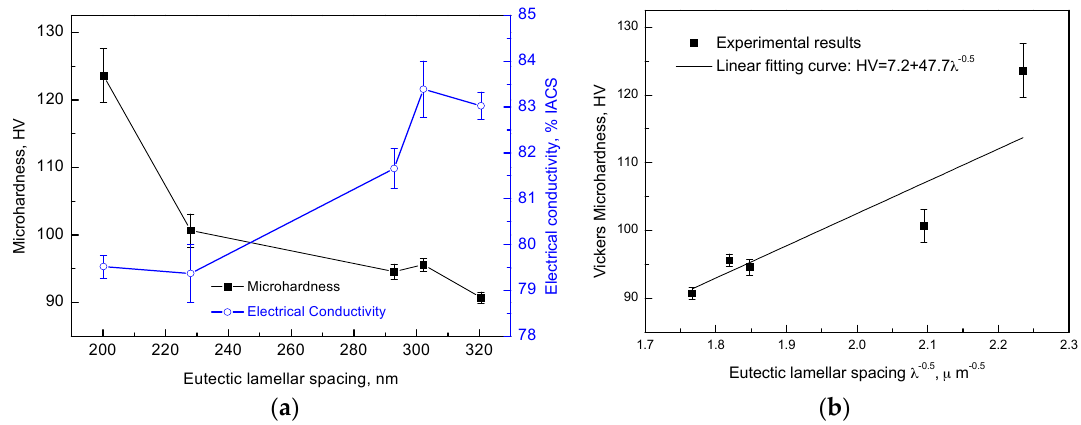
Figure 4. ( a ) Microhardness and electrical conductivity plotted as the ELS of DS Ag-Cu eutectic alloys with different MFs and growth rates; ( b ) Variation of microhardness as a function of the reciprocal square root of average interlamellar spacing for as-DS Ag-Cu alloy. Table 1. The mechanical and electrical properties of as-DS and as-rolled Ag-Cu alloys.